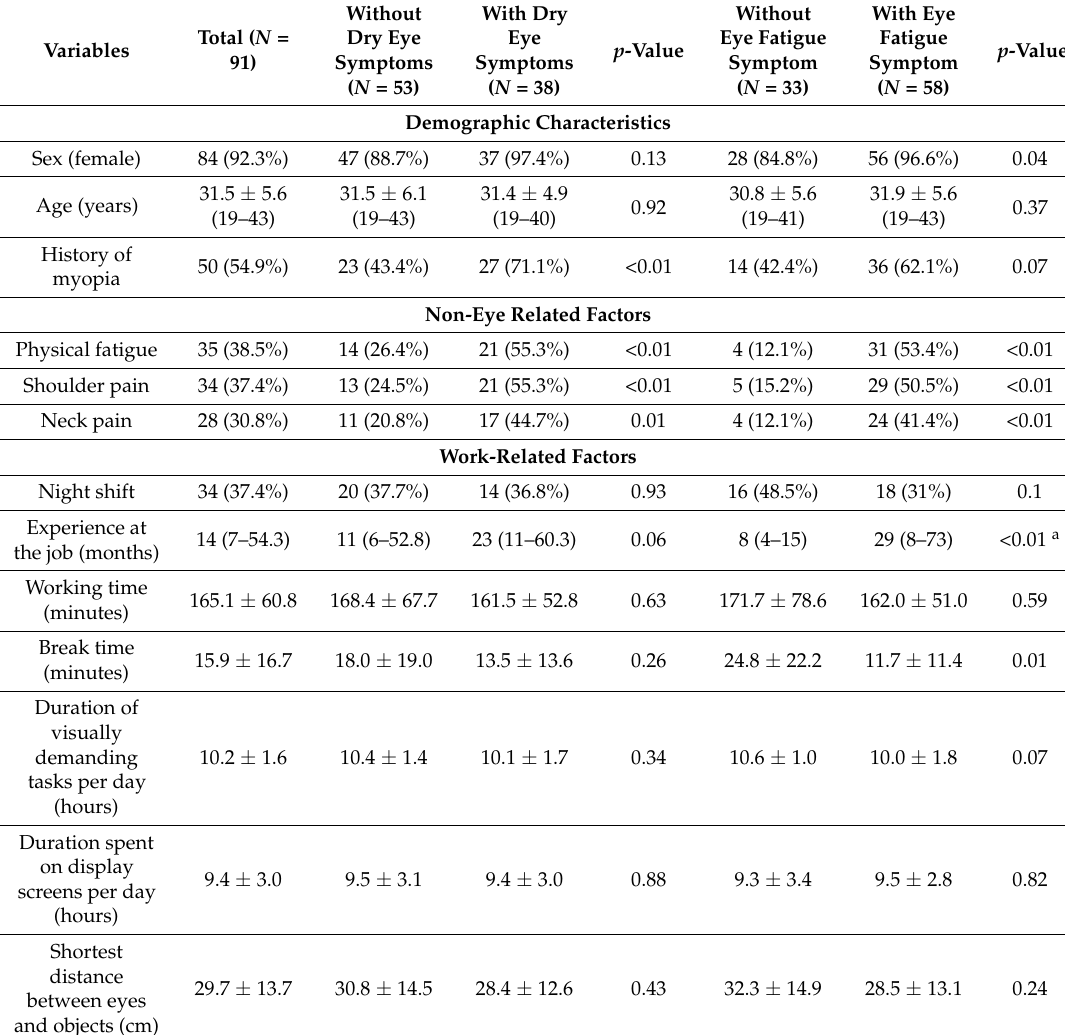
Table 1. Distribution of demographic characteristics and work-related factors, stratified by symptoms of dry eye and eye